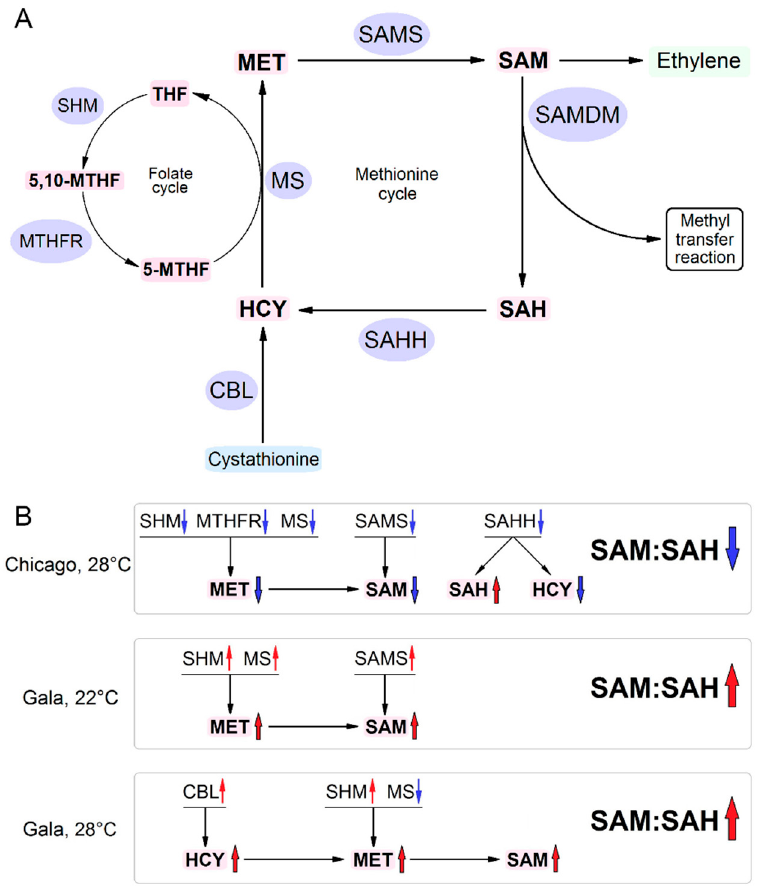
Figure 1. A tentative model showing possible mechanisms determining susceptibility or resistance of potato plants to PVY. ( A ) Schematic representation of the methionine cycle (MTC) in healthy cells. Metabolite (shown in pink) flow directions are presented by arrows, while the enzymes involved in their bioconversion are marked in blue. CBL, cystathionine β -lyase; HCY, homocysteine; MET, methionine; MS, methionine synthase; THF, tetrahydrofolate; 5-MTHF, 5-methyltetrahydrofolate; 5,10-MTHF, 5,10-methylenetetrahydrofolate; MTHFR, methylene tetrahydrofolate reductase; SAH, S-adenosyl-homocysteine; SAHH, S-adenosyl-homocysteine hydrolase; SAM, S-adenosyl methionine; SAMS, S-adenosyl methionine synthetase; SHM, serine hydroxymethyltransferase; ( B ) Schematic representation of the changes in expression of key MTC-related enzymes and MTC metabolites in response to PVY. Black arrows show enzyme pathway and metabolite flow directions. Blue and red arrows indicate down- and up-regulation, respectively. PVY infection in Chicago plants at higher temperature causes down-regulation of key MTC (MS, SAMS, SAHH) and MTC-related folate cycle (SHM, MTHFR) enzymes, leading to the decrease of SAM and increase of SAH [5]. This would suppress SAM-dependent methylation reactions and decrease ethylene production, leading to a great increase in plant susceptibility to PVY. At normal temperature, PVY infection did not affect expression of MTC enzymes, and plants display much lower susceptibility to PVY compared with high temperature. PVY infection in Gala plants at higher temperature causes up-regulation of MS, SAMS and SHM, leading to the increase of SAM levels and SAM:SAH ratio (at 8 dpi). At higher temperature, Gala plants responded to PVY by up-regulation of CBL and SHM, also leading to increased SAM levels and SAM:SAH ratio. Gala plants remain resistant to PVY at both normal and high temperatures.